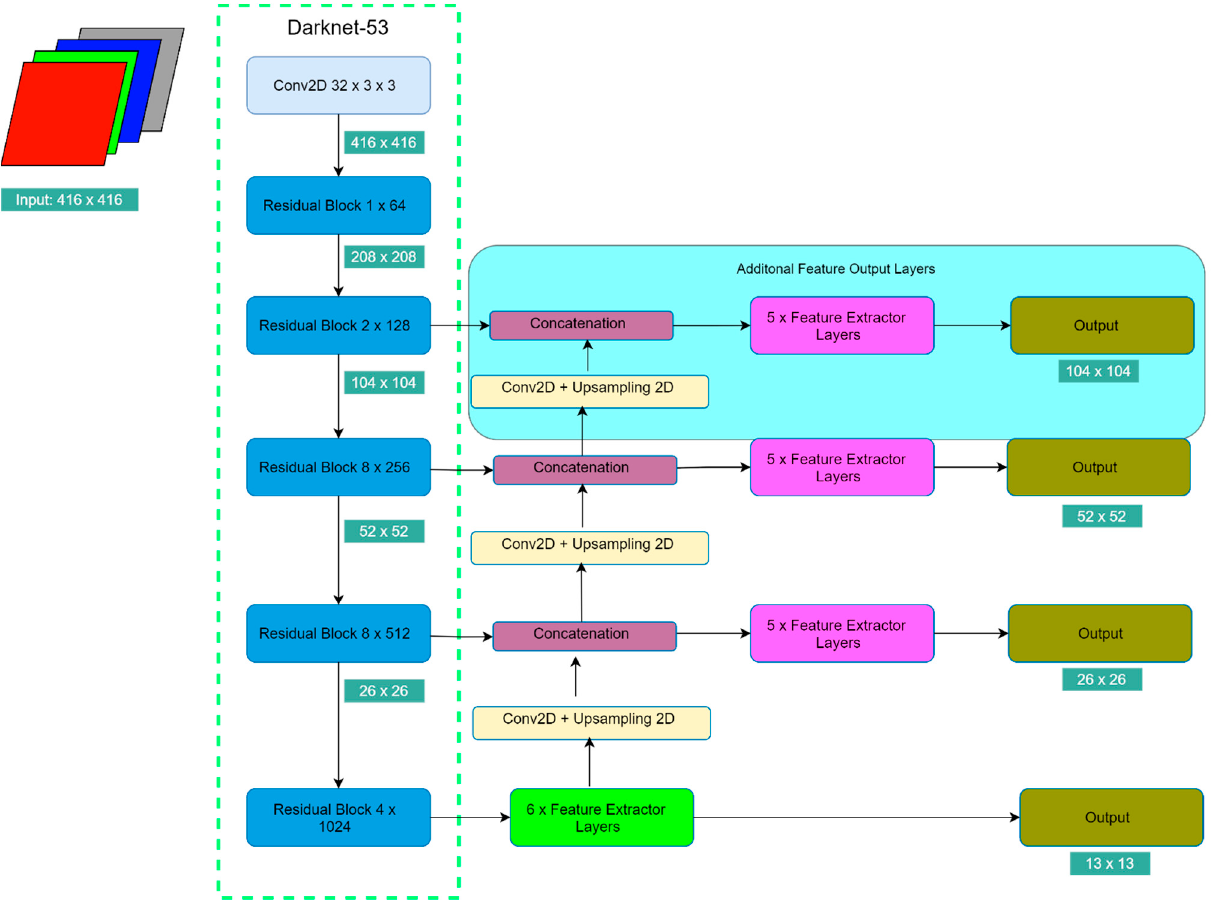
Figure 4. The optimized YOLO v3 architecture for improving detection accuracy. YOLO works by dividing the image into S × S grids. The output of the original YOLO has three resolution of grids: 13 × 13, 26 × 26 and 52 × 52, whereas it does not cover the small pedestrian well. Therefore, a new additional feature output is proposed, so it can handle smaller pedestrians with the grid size of 104 × 104. This deep neural network is named as YOLO-4L.